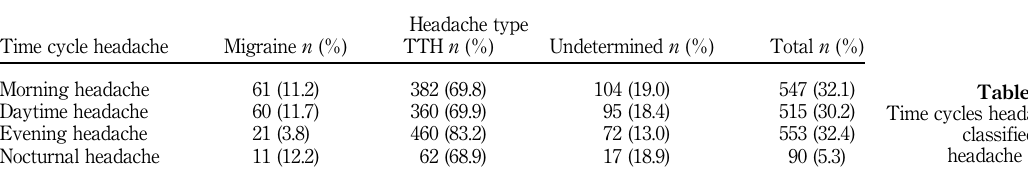
Table VI. Time cycles headache classified by headache